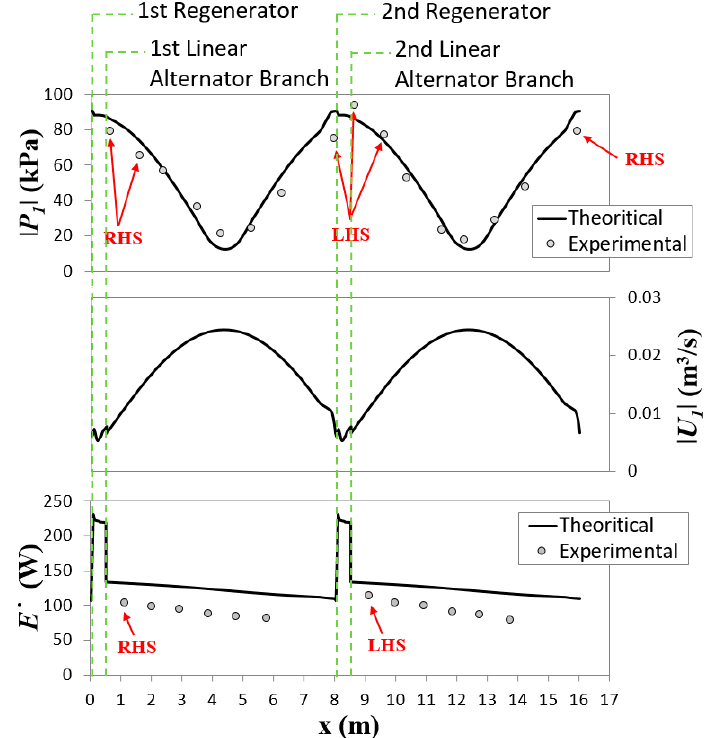
Figure 3. Distribution of pressure amplitude, volumetric velocity and acoustic power along the engine.